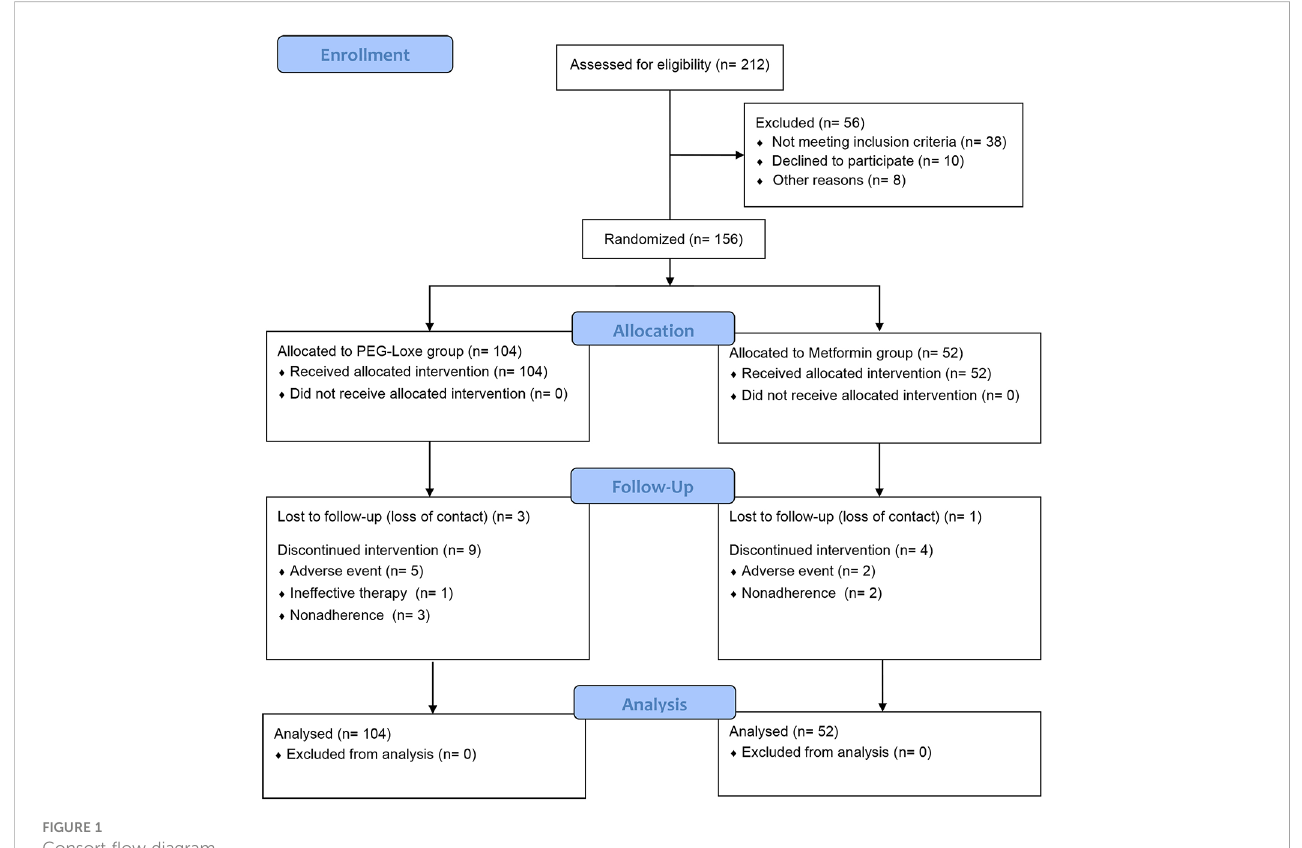
FIGURE 1 Consort fl ow